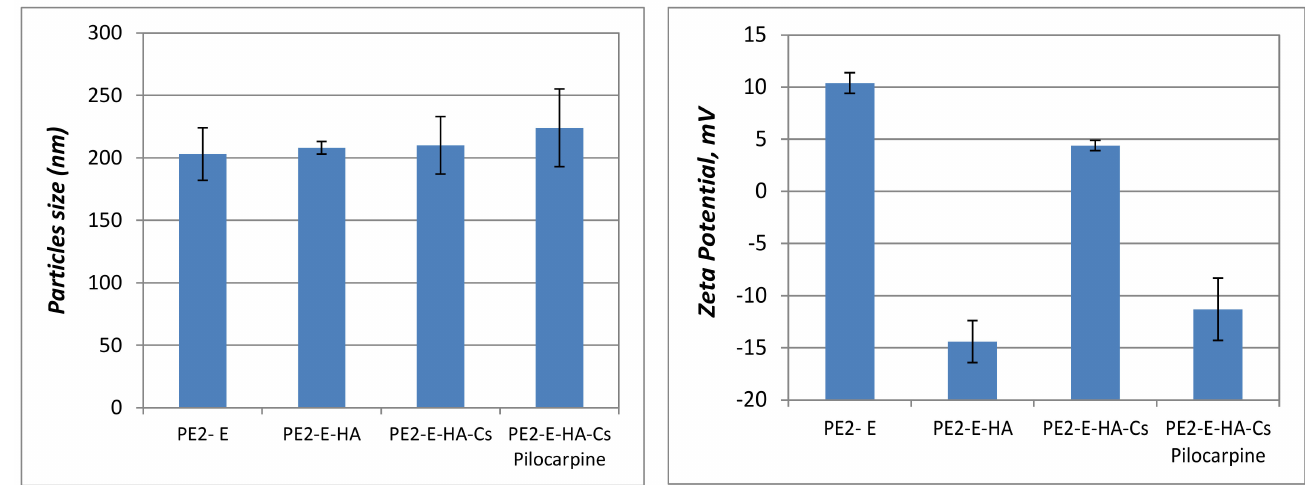
Figure 4. Size (nm) and zeta potential (mV) for pre-emulsion prepared with vitamin E (PE2-E), particles coated with sodium hialuronate (PE2-E-HA), particles coated with sodium hialuronate and chitosan (PE2-E-HA-Cs) and particles coated with biopolymers and pilocarpine